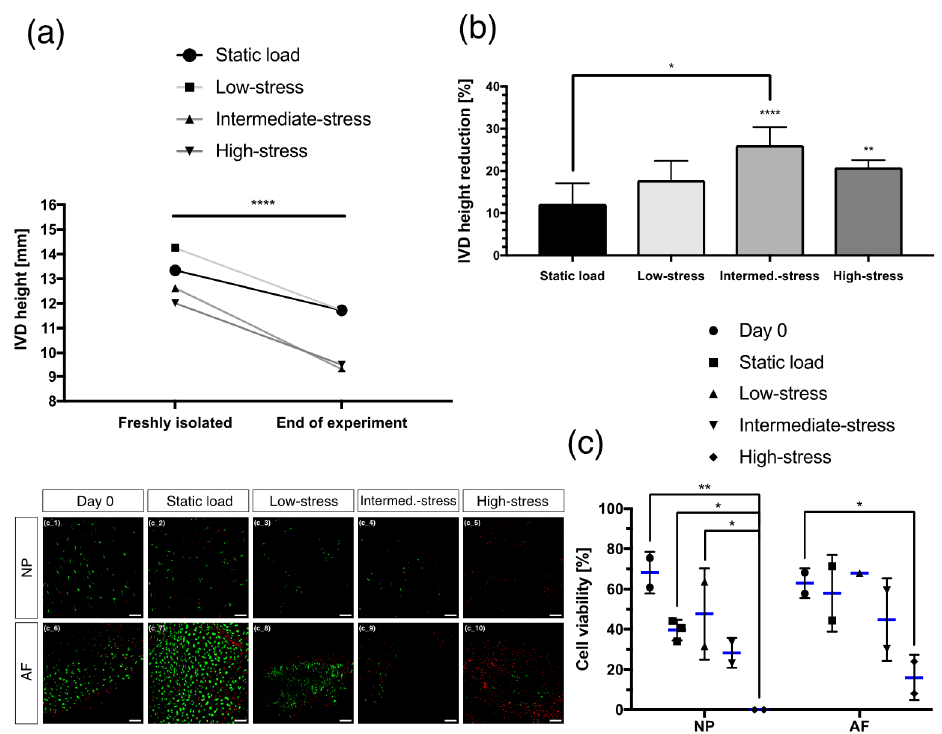
Figure 1. ( a ) Changes in the absolute IVD height under the influence of different loading regimes for seven days. Mean, N = 6–7. ( b ) Changes in the relative IVD height after seven days of loading with different loading regimes and compared to the initial IVD height after its dissection. Mean ± SD, N = 6–7. ( c ) Cell viability in the nucleus pulposus (NP) and in the annulus fibrosus (AF) at the end of each loading regime. Living cells were stained with calcein-AM (green) and dead cells with ethidium homodimer (red). Scale bar = 100 µm. Mean ± SD, n = 1–3. p -value: * < 0.05, ** < 0.01, **** < 0.0001.